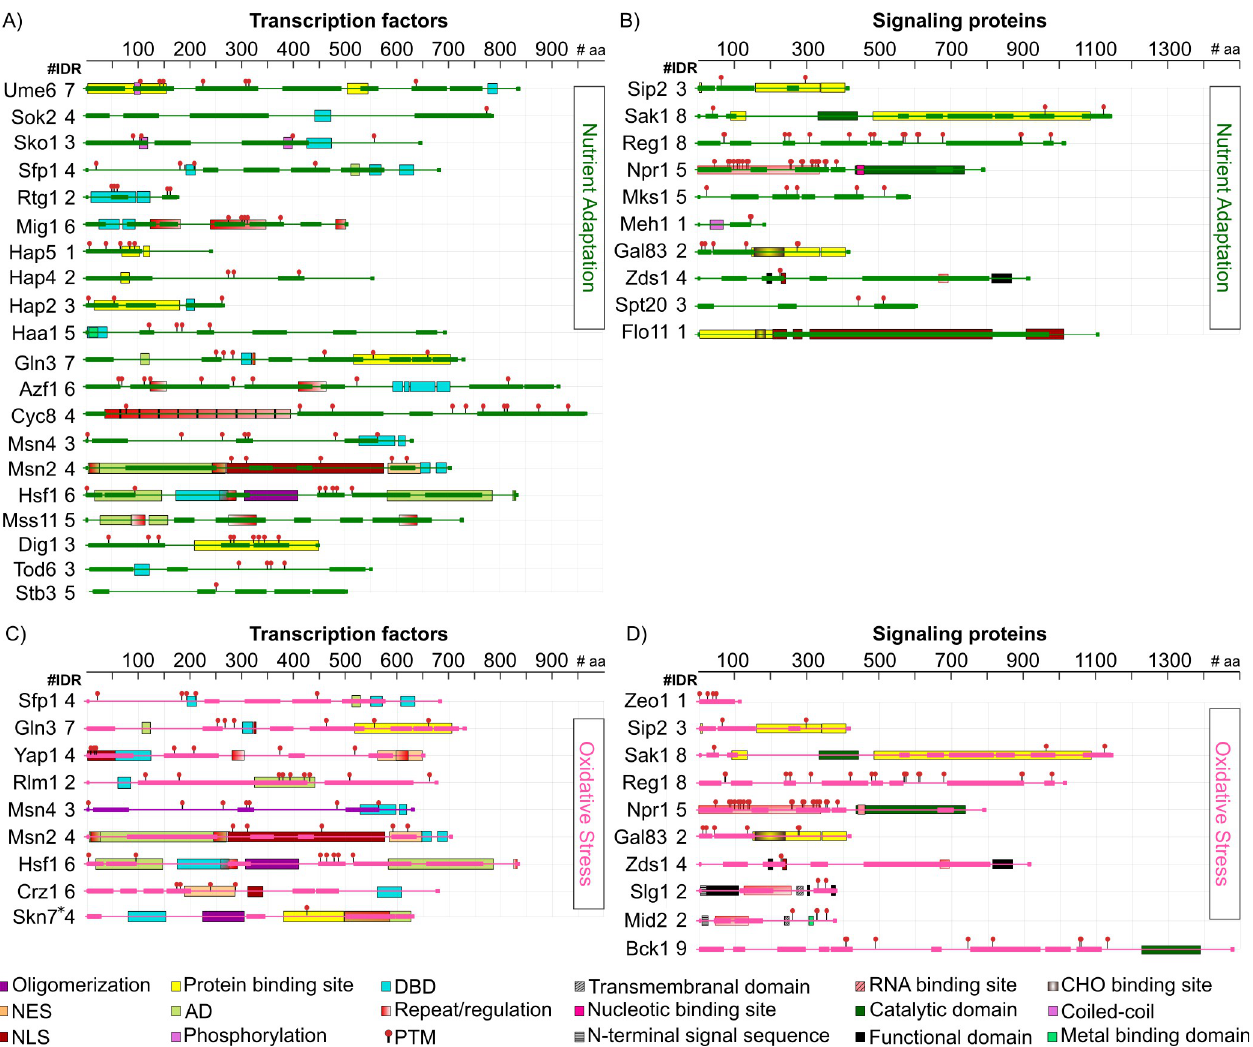
Fig 5. IDRs and functional domains in IDTFs and in signaling proteins involved in nutrient adaptation and oxidative stress response signaling pathways. (A and B) nutrient adaptation and (C and D) oxidative stress. The functional domains shown in this figure are those supported by experimental evidence. NES: Nuclear Export Sequence; NLS: Nuclear Localization Sequence; TAD: Transcription Activation Domain; DBD: DNA Binding Domain; PTM: Post-Translational Modification; CHO: Carbohydrate Binding Site. IDRs are showed as bars in nutrient adaptation (green) and oxidative stress (pink). The rulers above each protein representation schemes indicate the number of amino acid